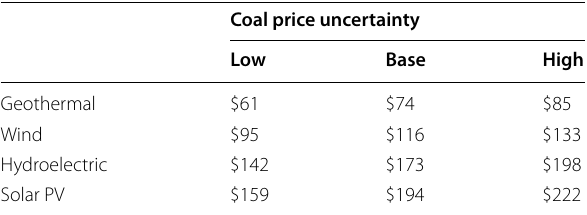
Table 3 Optimal trigger prices of coal at various coal price uncertainties Coal price